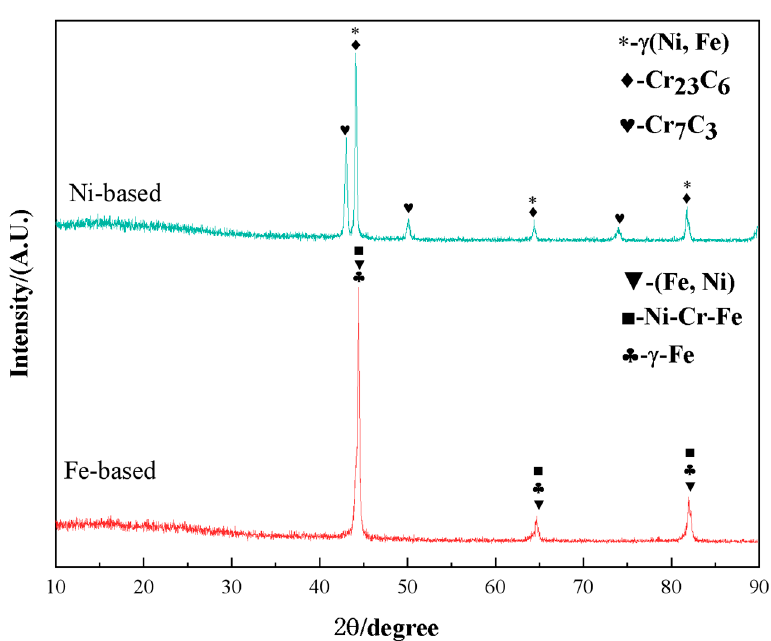
Figure 15. XRD patterns of the two samples.